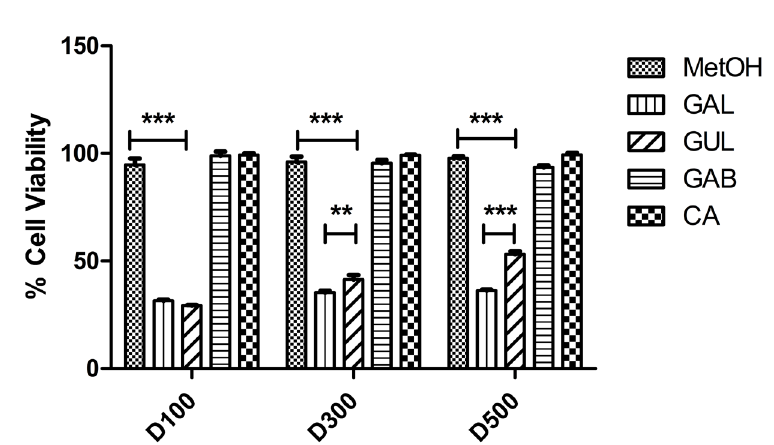
FIGURE 3 - Effect of Gauchito (GA) and Guri (GU) extracts on tumor cell viability. SH-SY5Y human neuroblastoma cells were treated for 72h with dilutions 1:100 (D100), 1:300 (D300) and 1:500 (D500) of vehicle (MeOH, negative Control), GA or GU leaf extracts (GAL and GUL; D100 = 40 µg/mL, D300 = 13 µg/mL, D500 = 8 µg/mL), GA bracts (GAB D100 = 15 µg/mL, D300 = 5 µg/mL, D500 = 3 µg/mL), chlorogenic acid (CA, D100 = 10 µg/mL, D300 = 3.3 µg/mL D500 = 2 µg/mL). Cell viability was evaluated by MTS assay. Mean ± SD is represented for each sample. The asterisks indicate the existence of a significant difference between the extracts and control (** p < 0.01 and *** p < 0.001 ANOVA statistical test followed by Bonferroni’s post-test was applied).